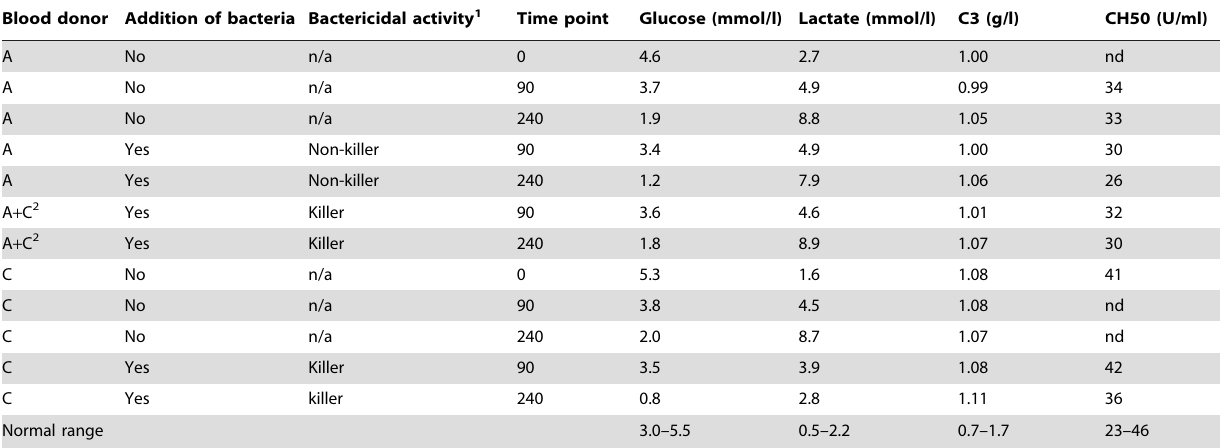
Blood donor Addition of bacteria Bactericidal activity 1